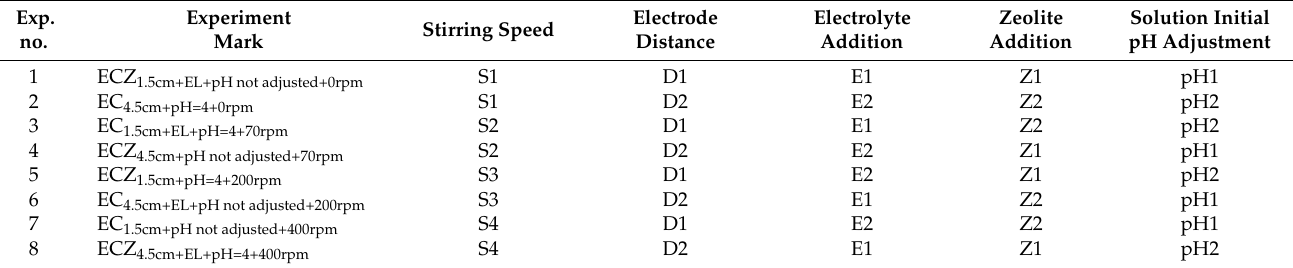
Table 2. Experimental plan and factor used for L8 (2 4 4 1 ) Taguchi